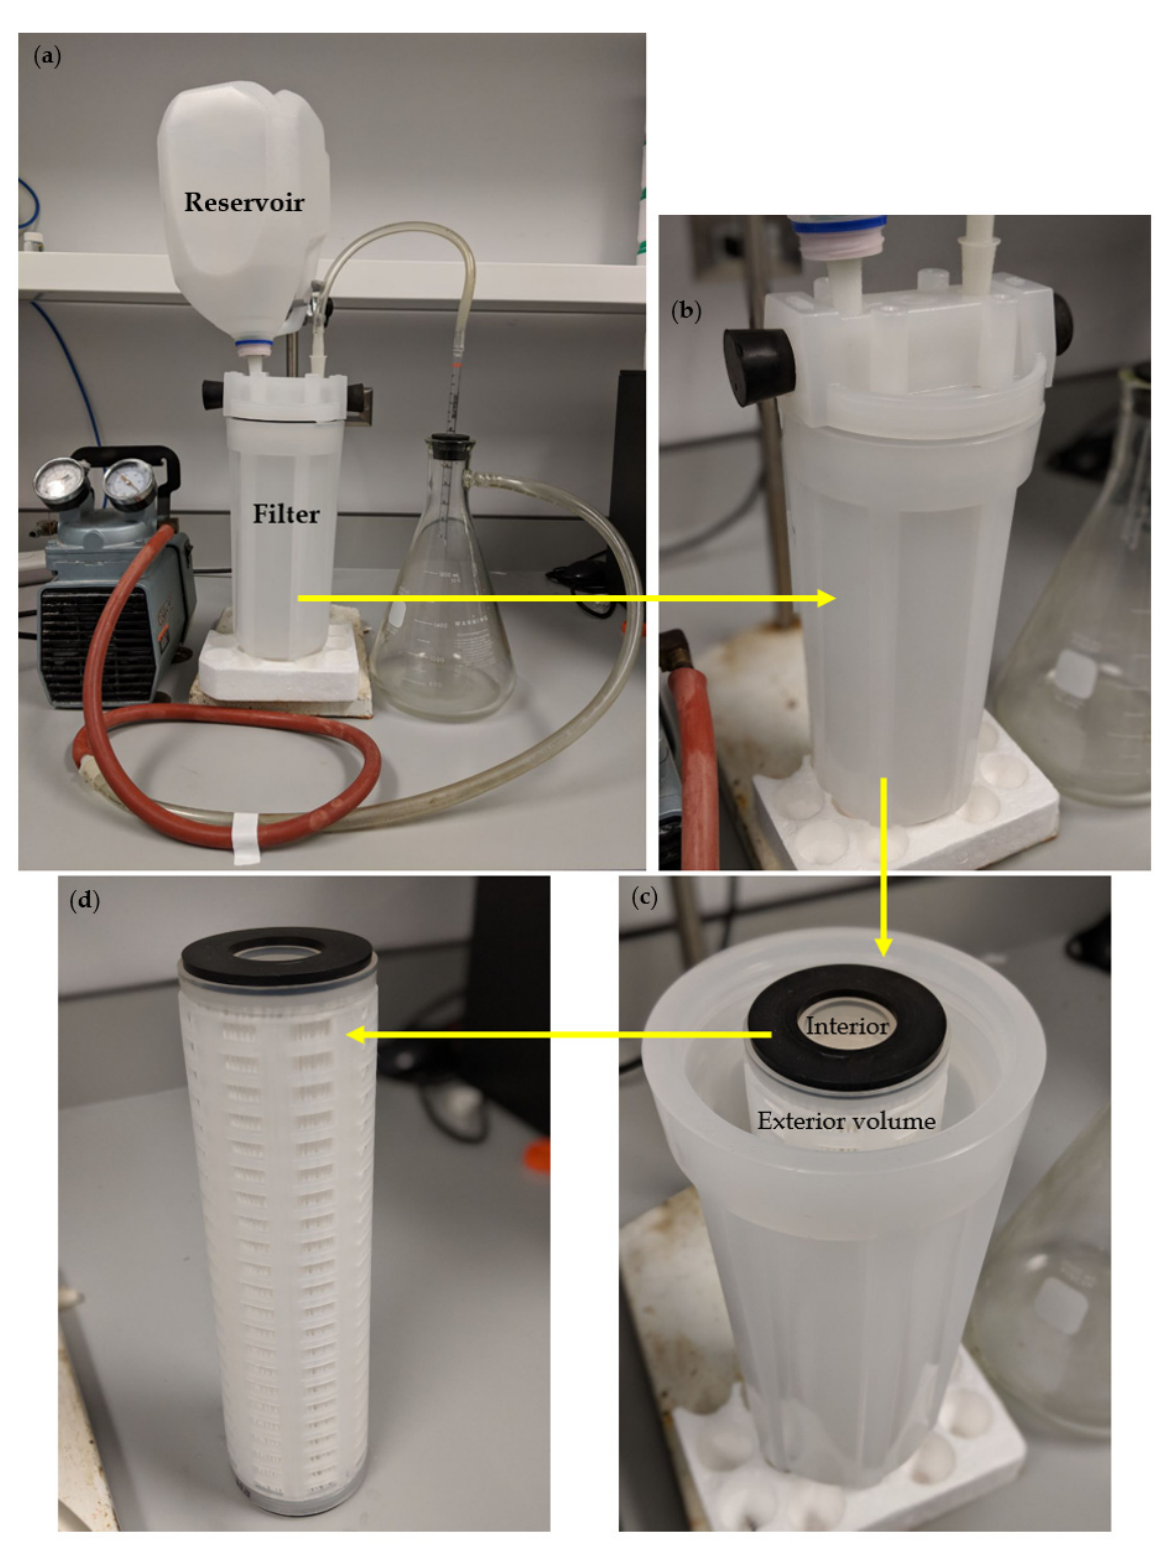
Figure 2. The setup for the large-scale (commercial) filter. ( a ): full system, ( b ): sealed filter chamber, ( c ): inner chamber and ( d ) 0.2 µm filter.